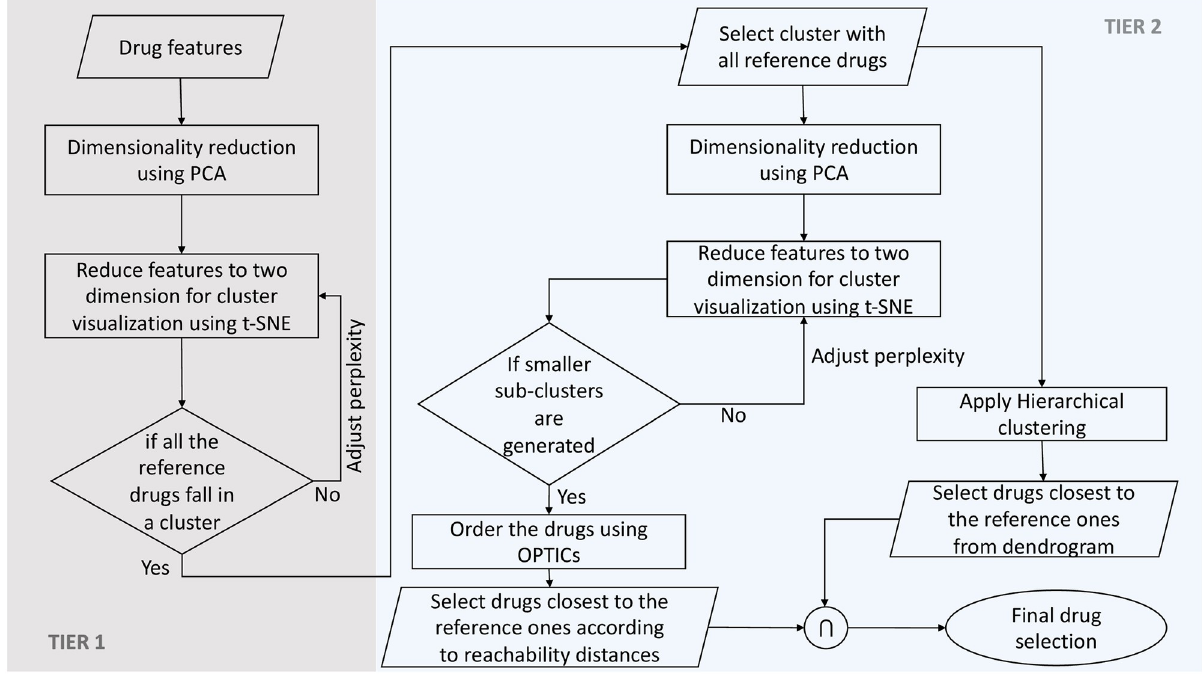
Fig 2. Flowchart of Two-Tier clustering approach.